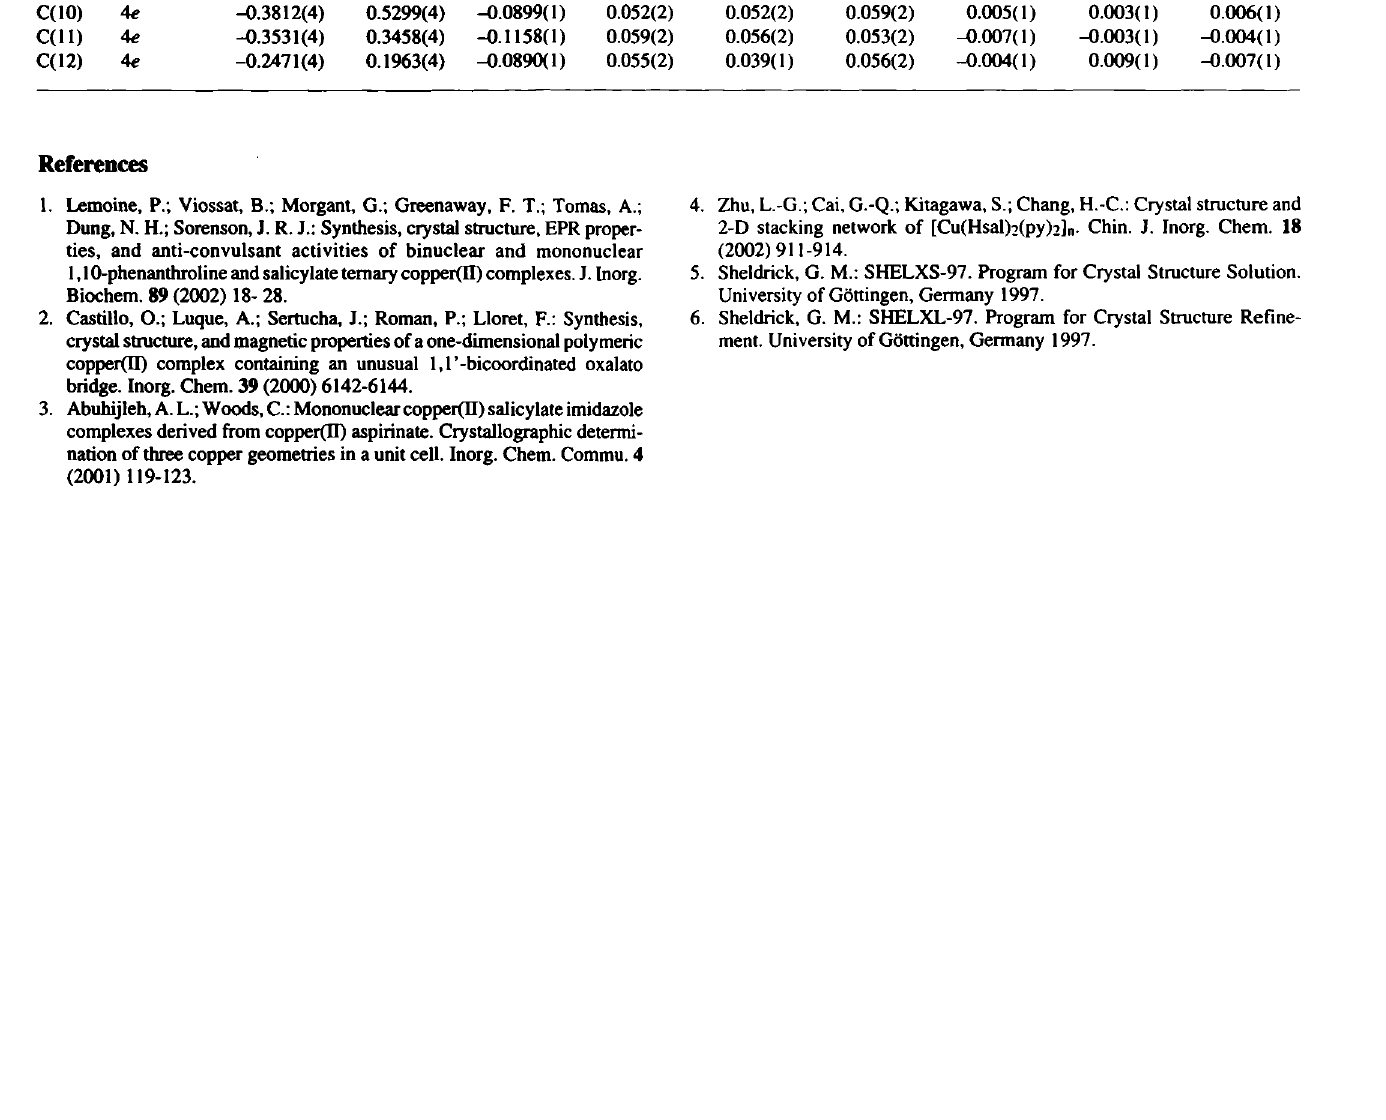
Table 3. Atomic coordinates and displacement parameters (in Â 2